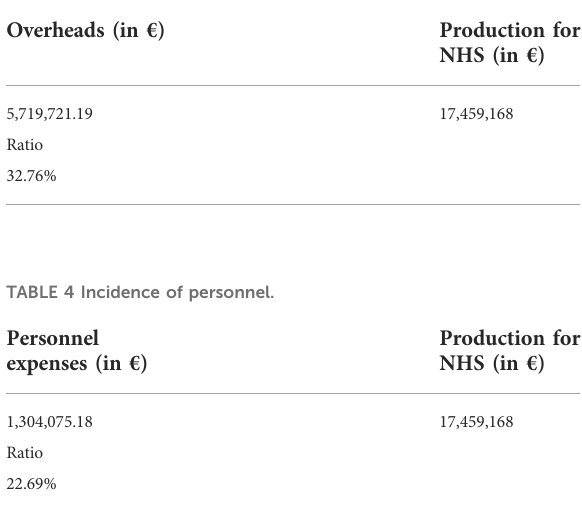
TABLE 2 Overall data collected from sponsor